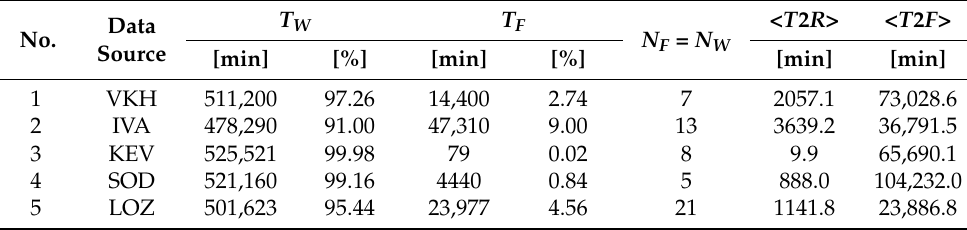
Table 2. Assessment of completeness of time series and indicators of data source reliability.